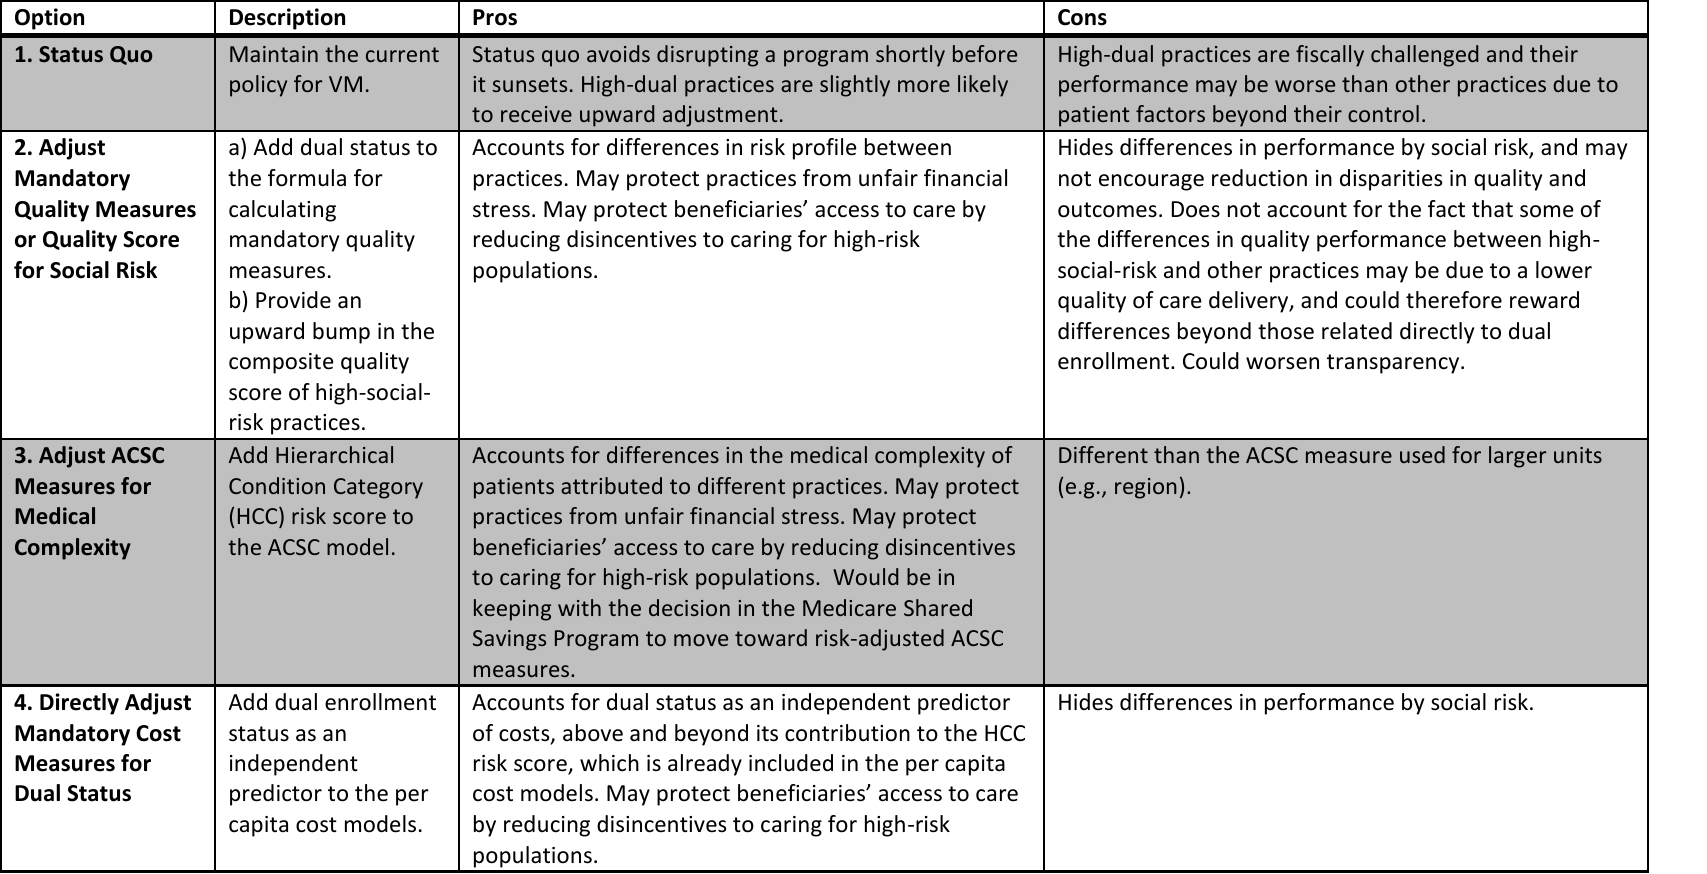
Table 10.16. Summary of Policy